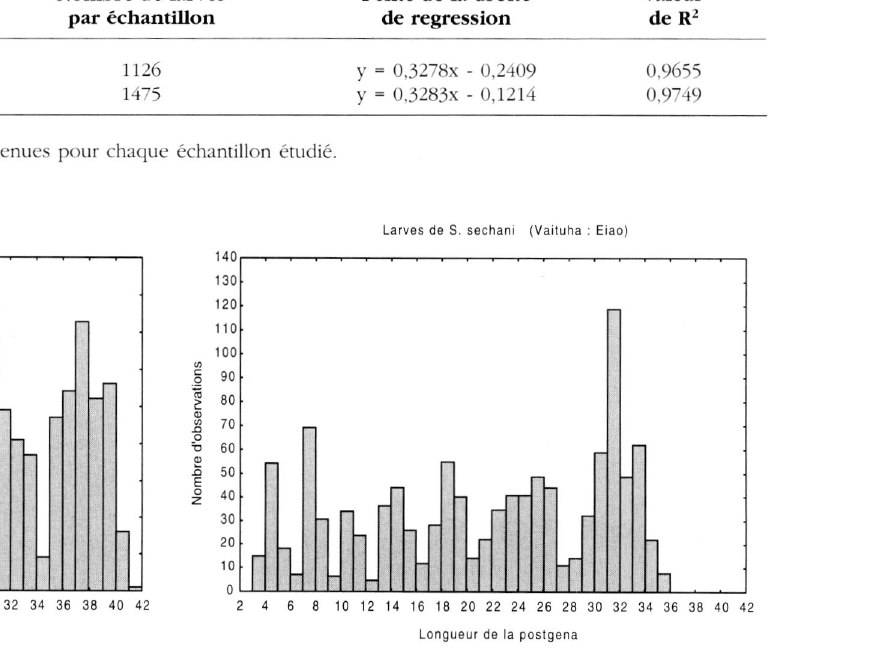
Fig. 4. - Repartition des frequences des valeurs du paramètre "a" de la postgena des larves étudiées.